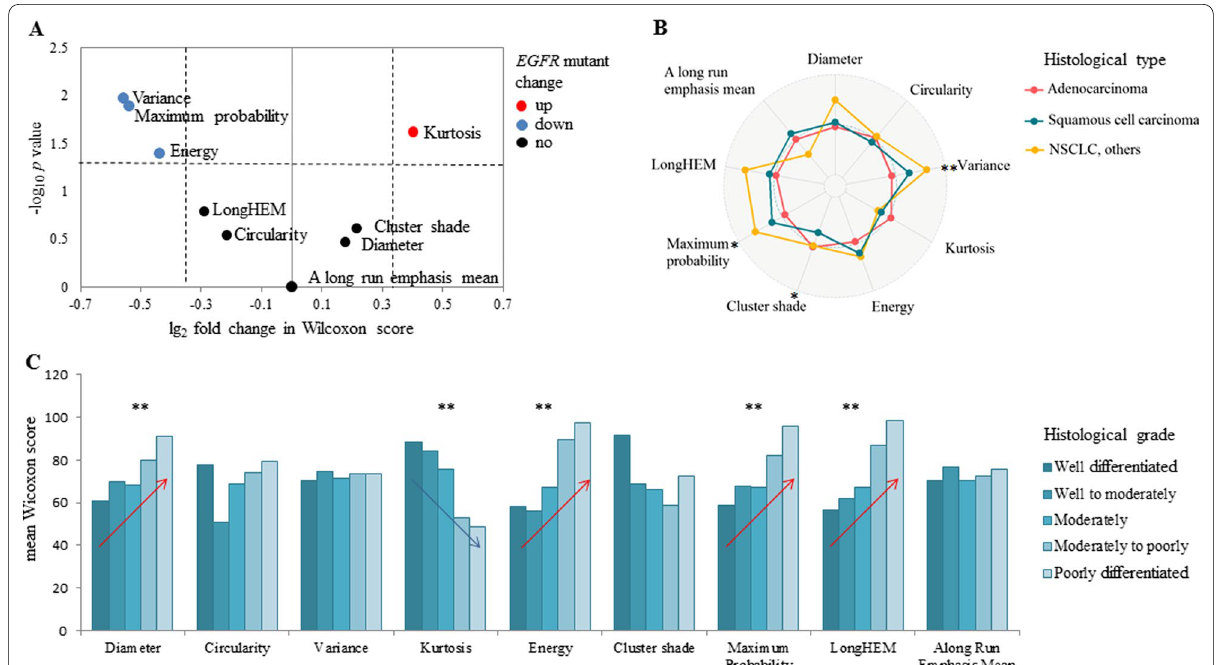
Fig. 2 Association of image metrics with gene and histopathological phenotypes. A Volcano plot showing the significantly up-regulated (red) and down-regulated (blue) image metrics ( p < 0.050) regarding EGRF mutation. B Radar plot of differentially expressed image metrics regarding histopathological type. C Dose–response plot of histopathological grade with image metrics. * p < 0.050; ** p < 0.010. EGFR: epidermal growth factor